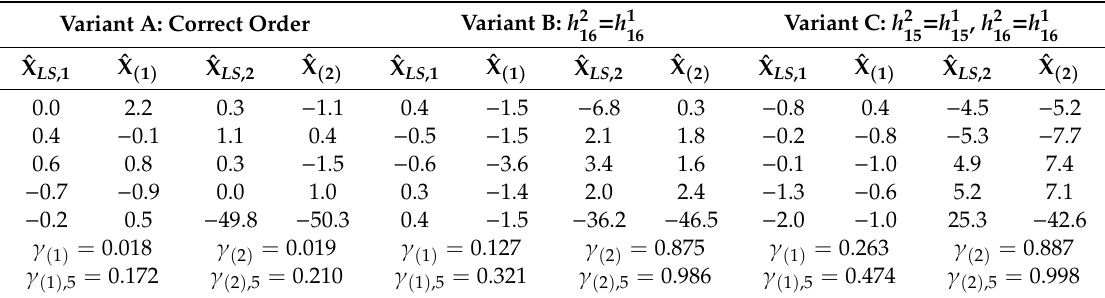
Table 3. The MC estimates of the point heights and SRs for the disturbed observation